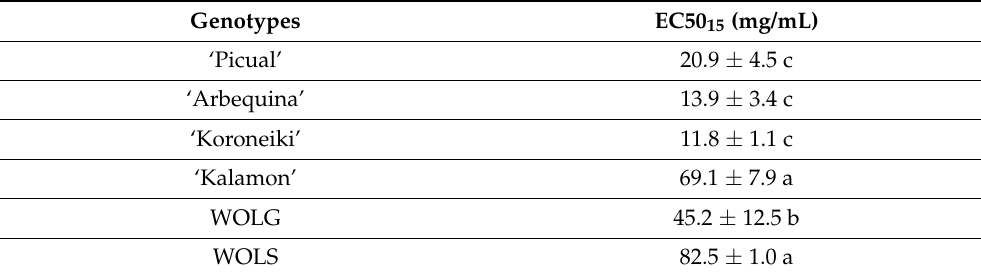
WOLG: wild olive leaves ( O.e . spp. oleaster ) from Greece; WOLS: wild olive leaves ( O.e . spp. oleaster ) from Spain. Lower case letters indicate significant differences among all different extracts from the genotypes according to Tukey’s test ( α <